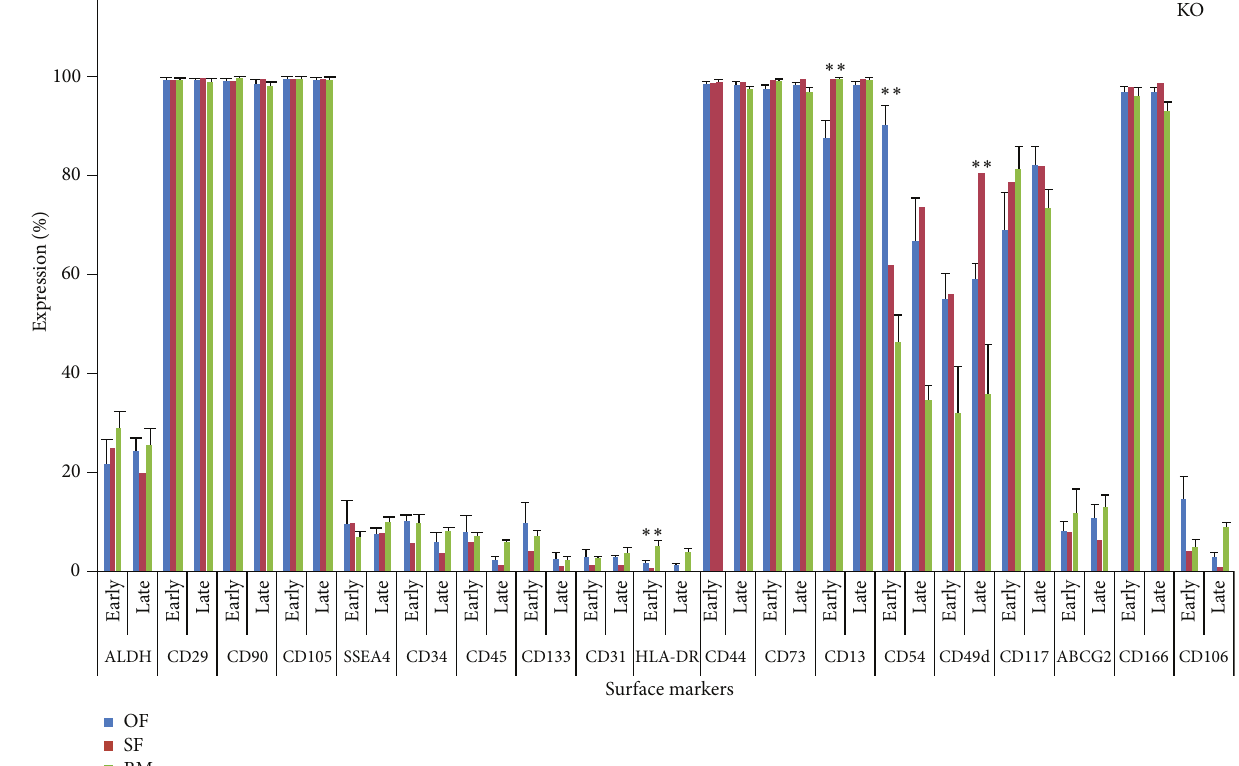
Figure 7: Marker expression profiling of MSCs cultured in DMEM-KO. Comparative Surface antigenic profiling of MSCs derived from omentum fat, subcutaneous fat, and bone marrow at early (P3) and late (P20) passages cultured in